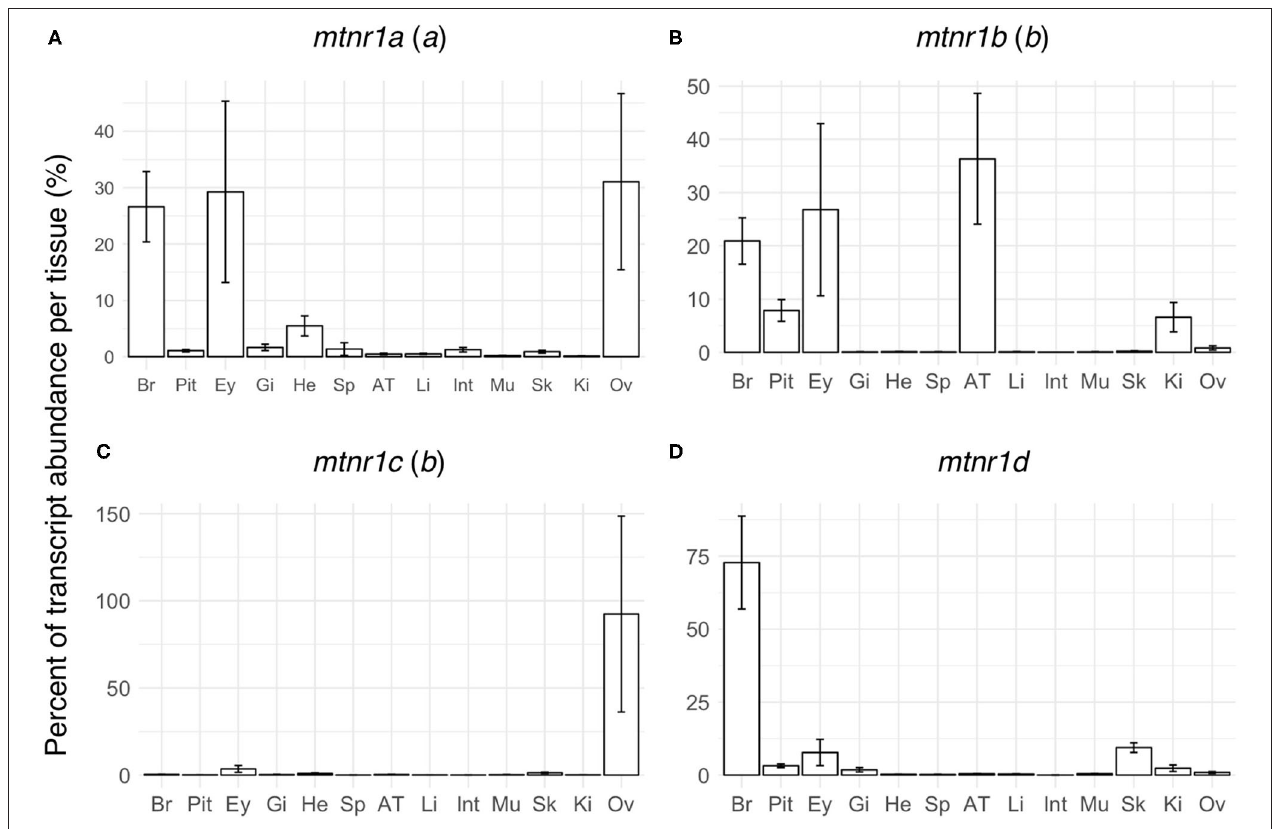
FIGURE 6 | Tissue distributions of the four melatonin receptors in reproductively active medaka females. Gene expression profiles of the four melatonin receptor paralogs: (A) mtnr1a, (B) mtnr1b , (C) mtnr1c , and (D) mtnr1d in brain (Br), pituitary (Pit), eye (Ey), gill (Gi), heart (He), spleen (Sp), adipose tissue (AT), liver (Li), intestine (Int), muscle (Mu), skin (Sk), kidney (Ki), and ovary (Ov) of reproductively active medaka females. The bar plots represent the relative expression calculated as the percentage of the mean of transcript levels (mean ± se) per tissue. The letter inside the parentheses indicates the 3R paralog